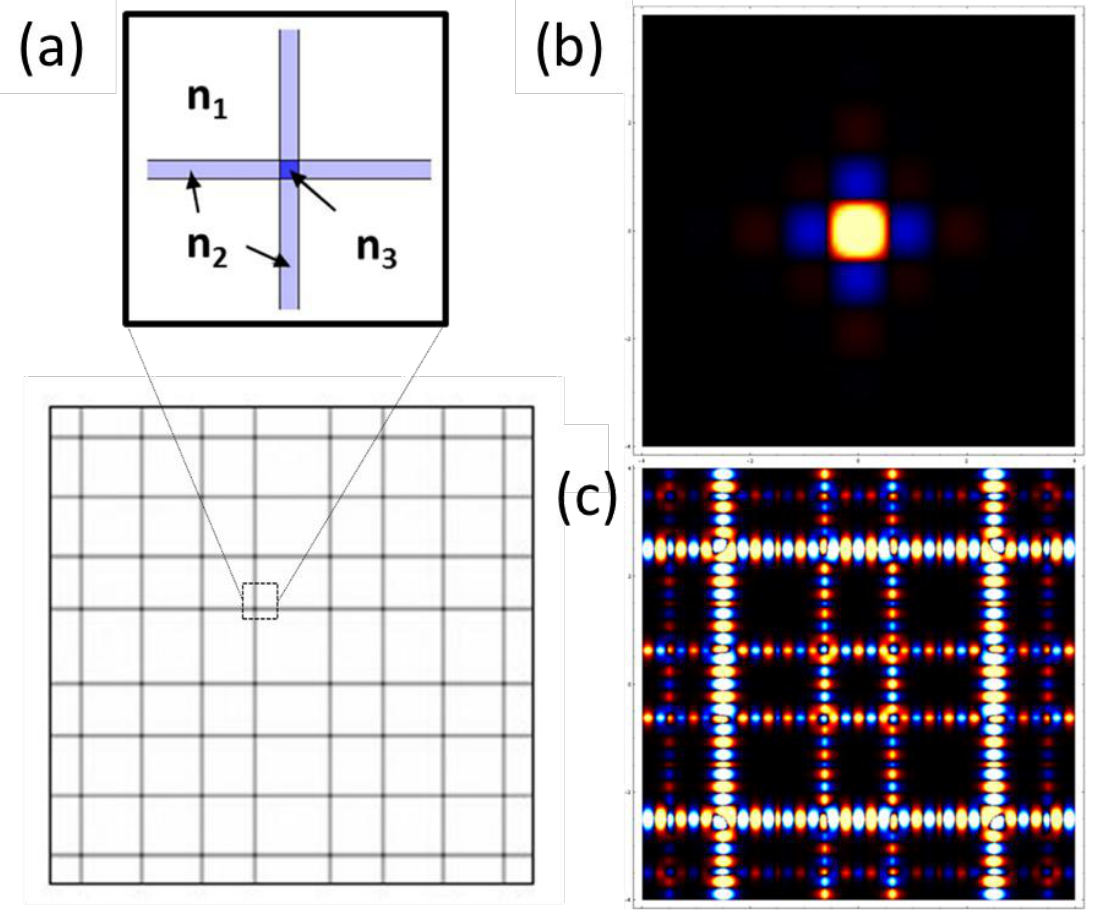
Figure 13. ( A ) Zoomed in crossing of glass webs separated by air of idealized Kagome structure. Index of the air, webs, and intersections are n 1 , n 2 , and n 3 , respectively. ( B ) Density plots of a